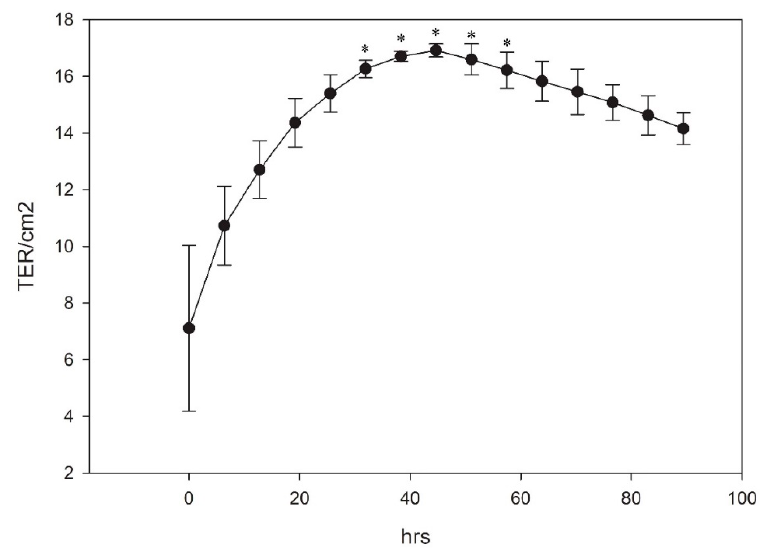
Figure 8. The cells were plated on transwell membranes and TER values measured every 6 h. The results represent mean ± SEM of 3 independent experiments. * indicates significantly different from 0 h.